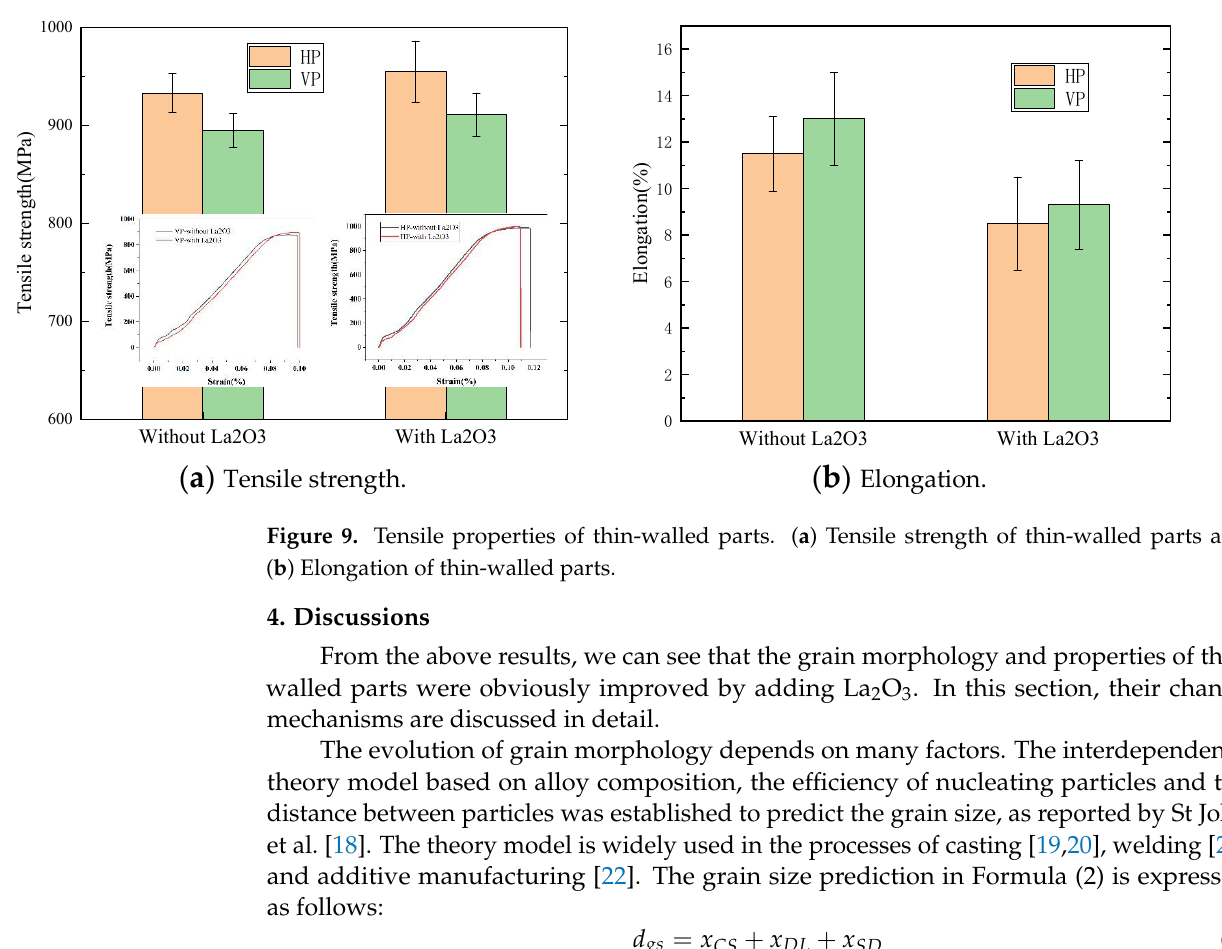
9 of 13 Figure 8. Microhardness distribution. ( a ) the microhardness of thin-walled parts, ( b ) the micro- hardness of HAZ and ( c ) the microhardness of top zone. The tensile properties of thin-walled parts are shown in Figure 9. The tensile strength of thin-walled parts in the vertical plane (VP) and the horizontal plane (HP) were meas- ured. The tensile properties are shown in Figure 9a. The HP tensile strength was greater